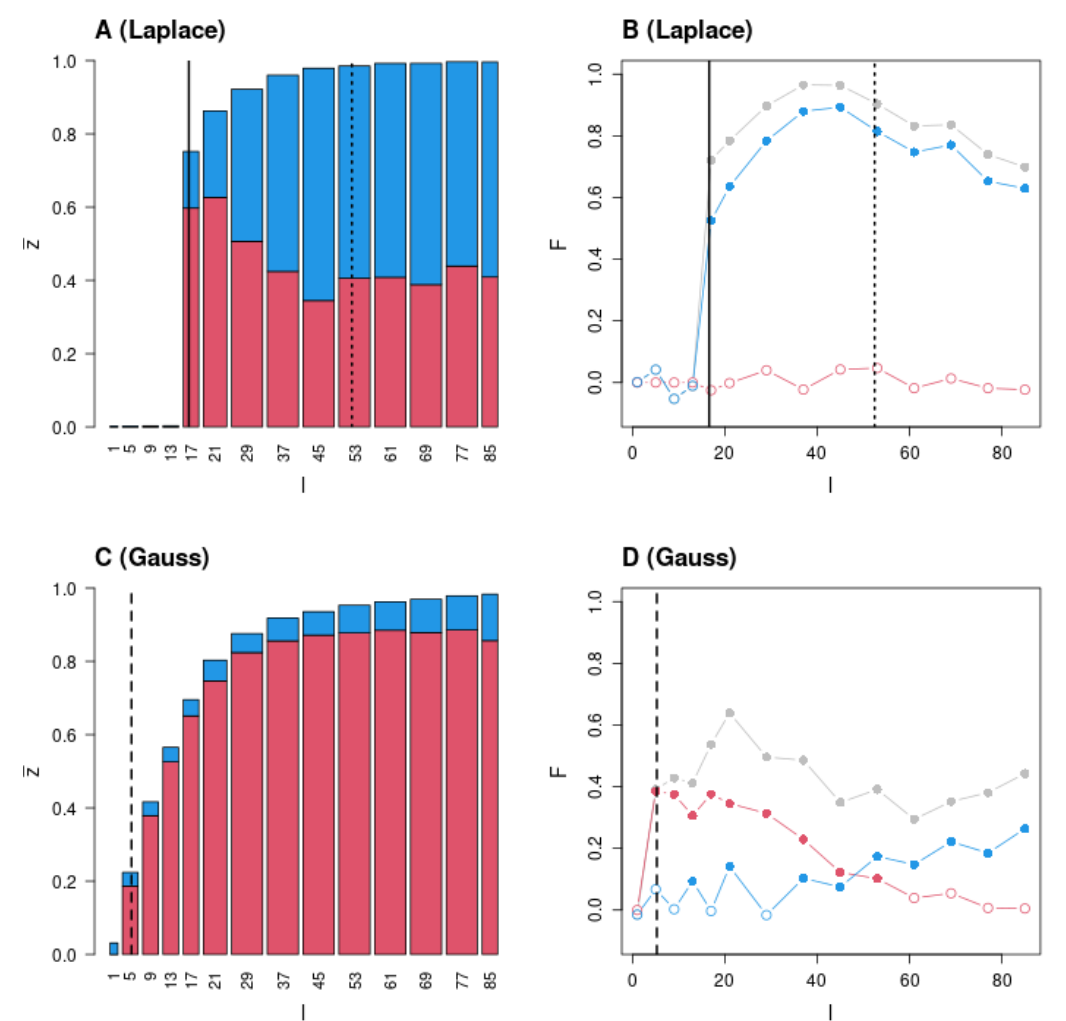
Figure 6 - L ong-term genetic architecture of local adaptation after the reconfiguration phase. The legend of the figure is identical to fig. 5, except that measures are taken on the long term, after 400 000